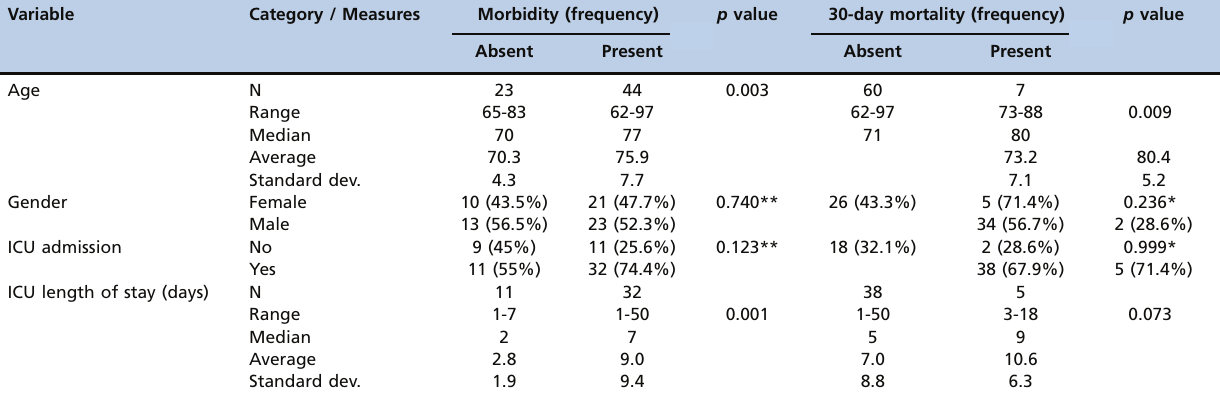
Table 3 - Distribution and statistical comparison of variables and their associations with morbidity and mortality. Variable